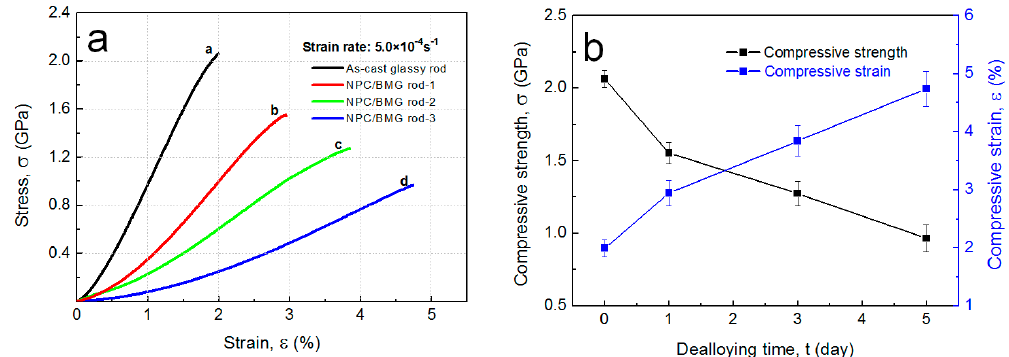
Figure 5. ( a ) Compressive stress-strain curves of the as-cast Cu 50 Zr 45 Al 5 BMG rod and the NPC/BMG composite rods; ( b ) Changes in the compressive strength and compressive strain of NPC/BMG composite rods with dealloying time.